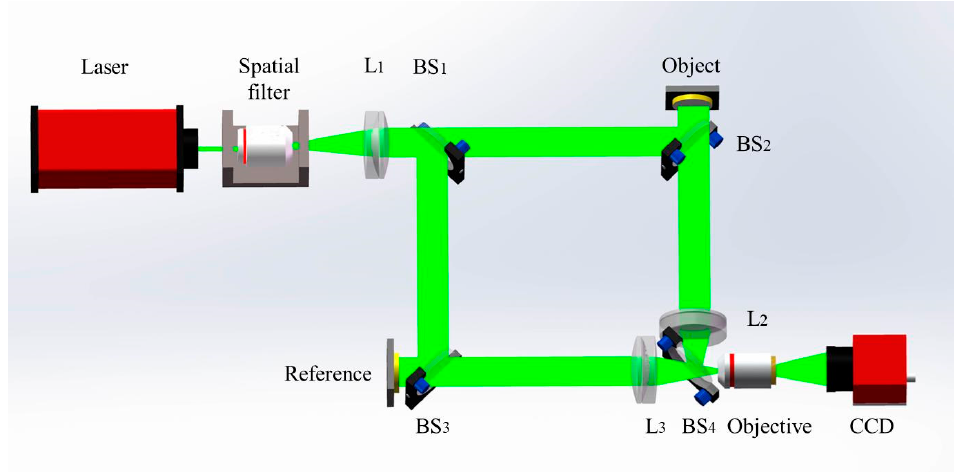
Figure 2. The schematic diagram of large-field microscopic speckle interferometry system. L 1 , L 2 , and L 3 represent lenses, BS 1 , BS 2 , BS 3 and BS 4 represent beam splitters.